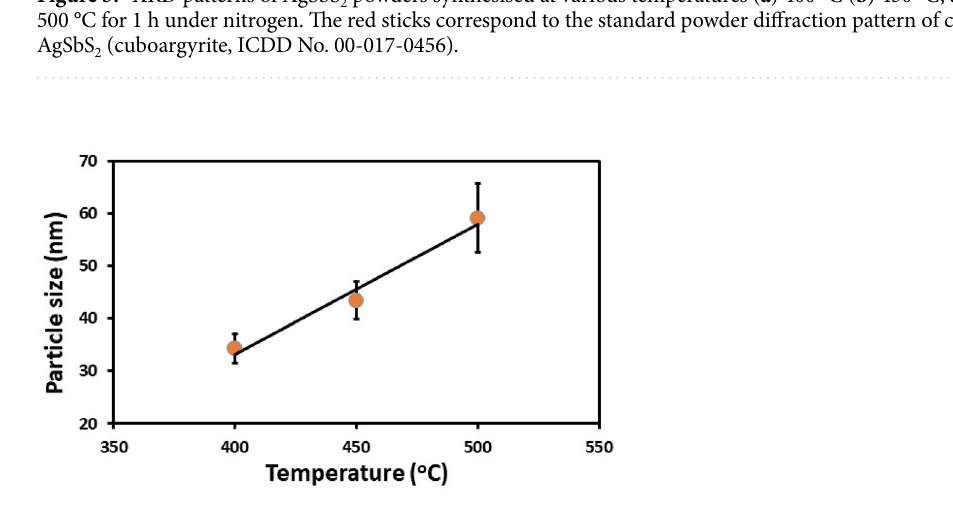
Figure 4. Average crystallite domain size of AgSbS 2 powders calculated using Scherrer’s equation as a function of synthesis temperature.